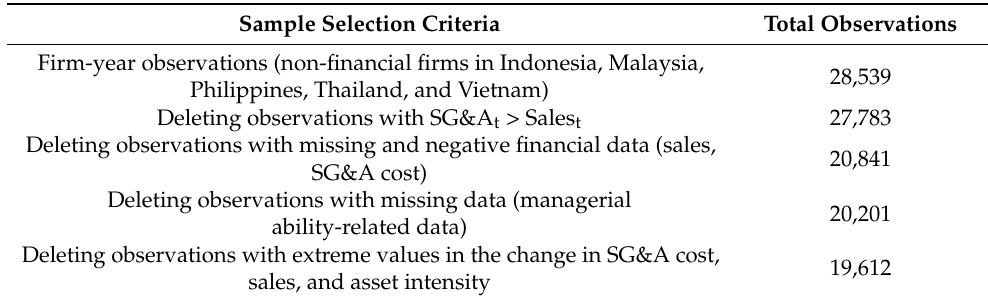
Table 3. Sample Selection Procedure. Sample Selection